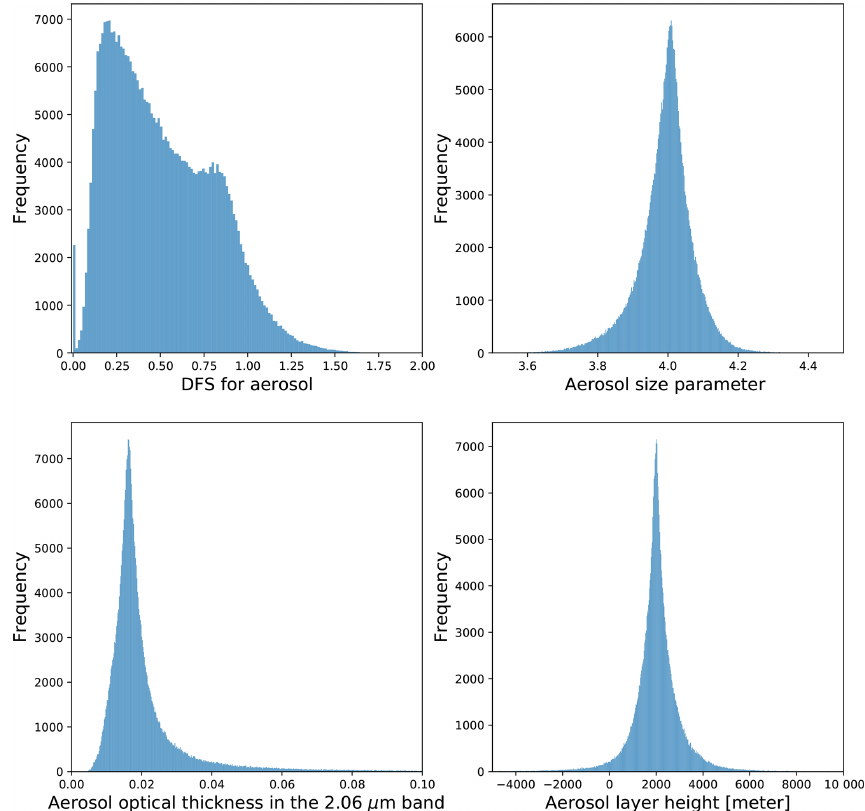
Figure 5. Histogram of DFS for aerosols, aerosol size parameter, aerosol optical depth, and aerosol layer height in the one-band retrievals.